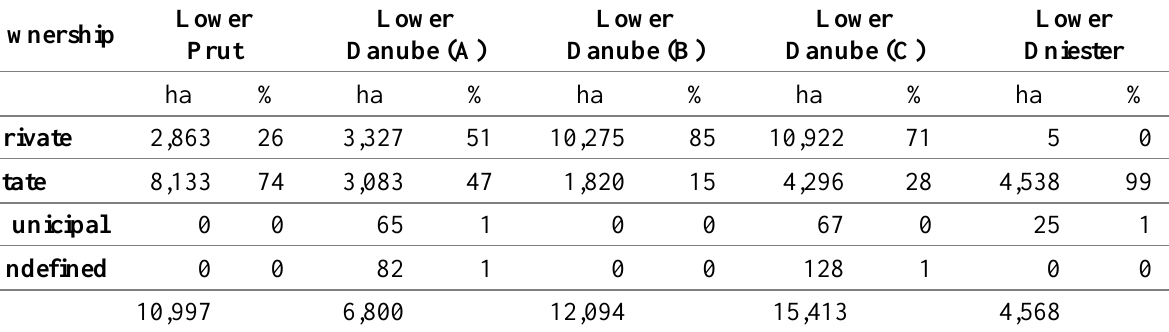
Table 3. Land ownership in the ReedBASE study sites (areas in ha, rounded). Source: ReedBASE project.